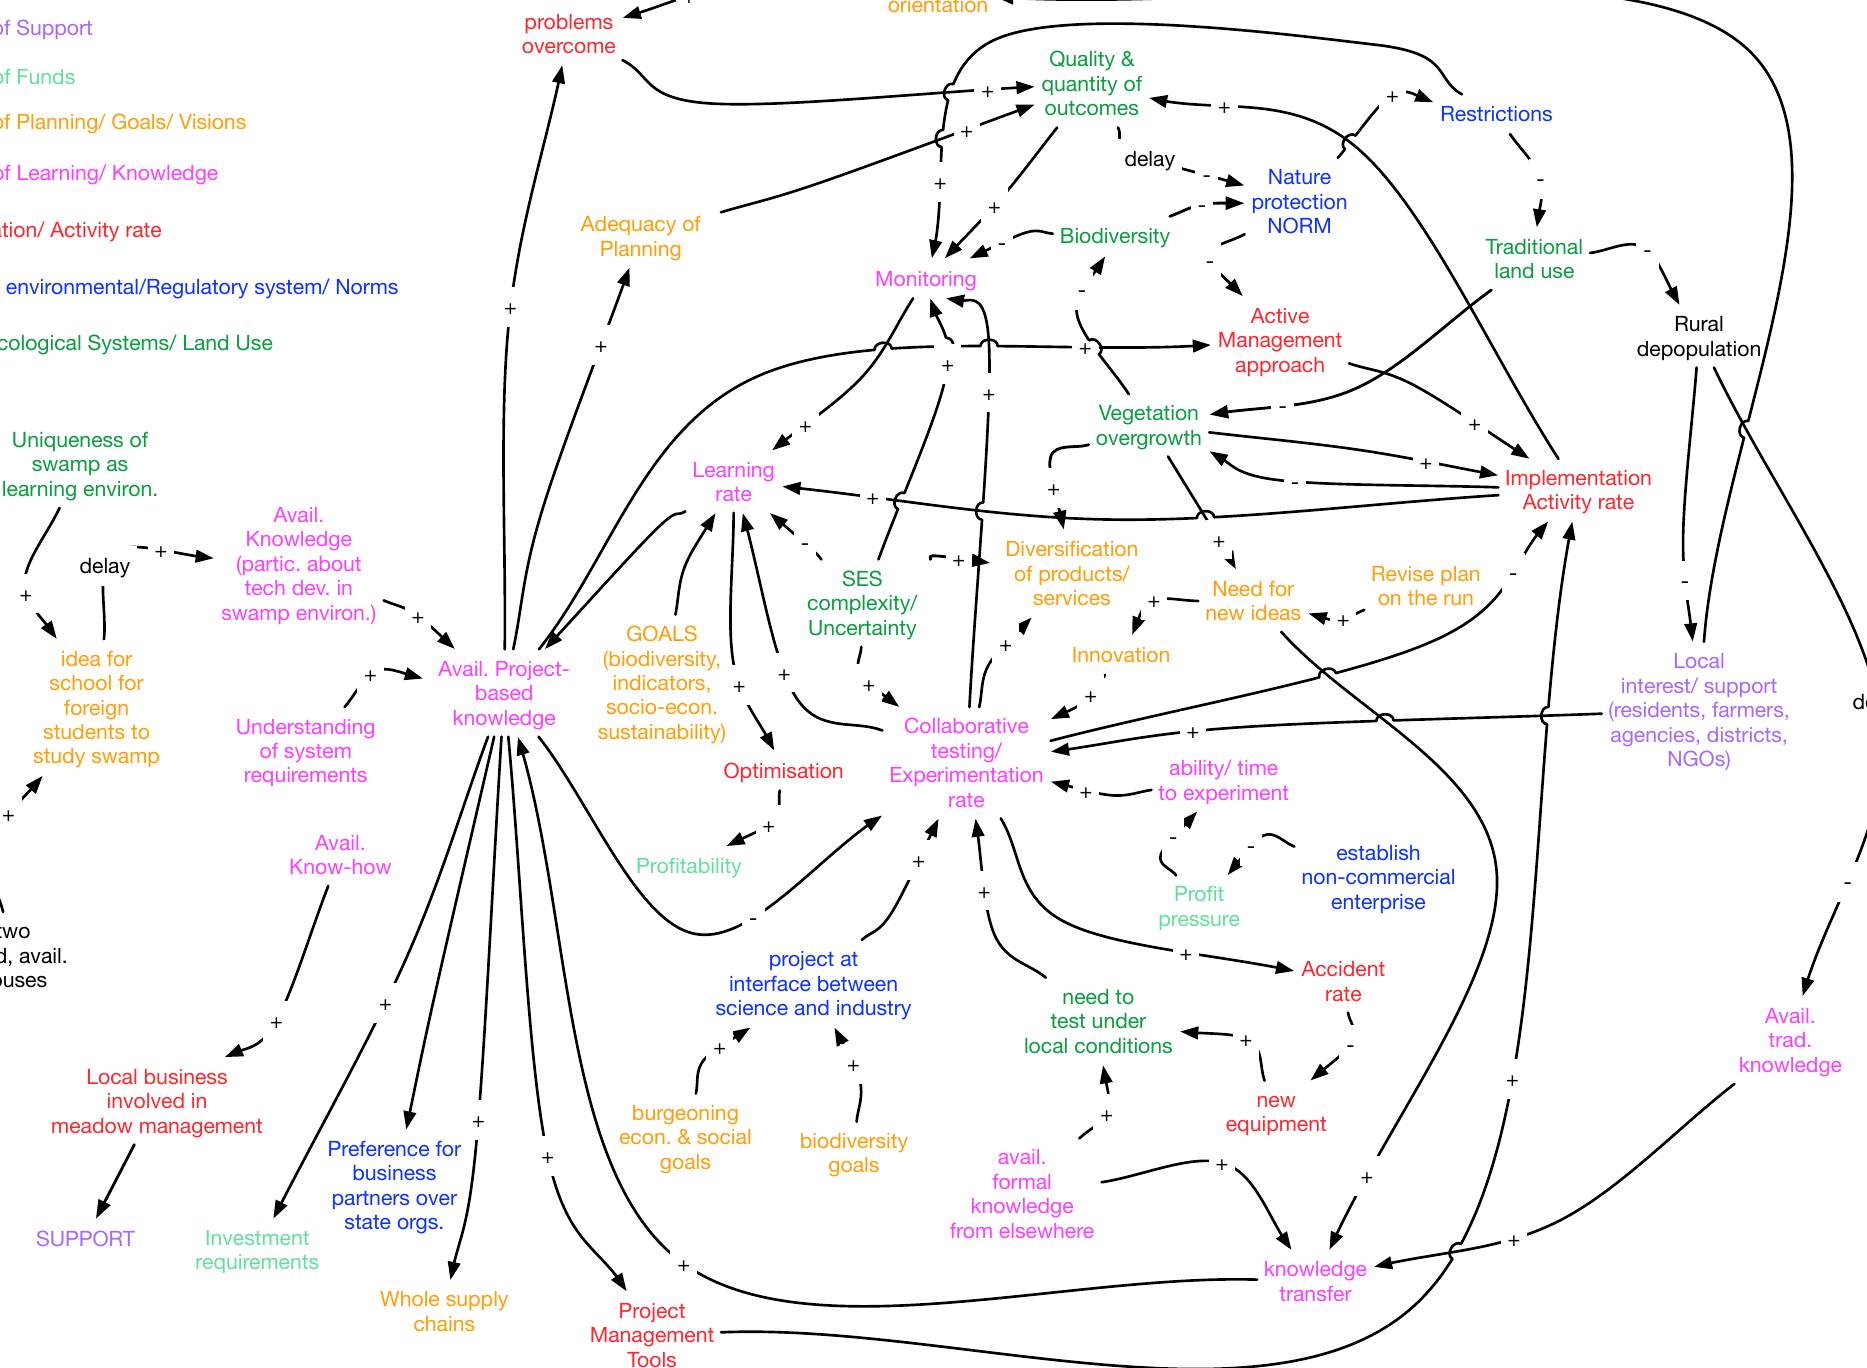
Figure A2:11. Case Birds, Theme: Learning,